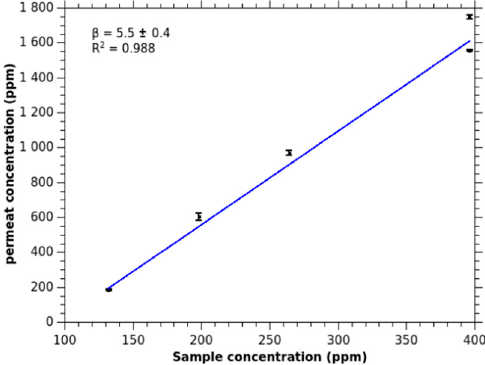
Figure 1. Calibration of ammonia signal as calculated from the ion signal ( m / z 18.034) for different feed concentrations (molar fraction in ppm). The pH of the solutions are set to 10.5.